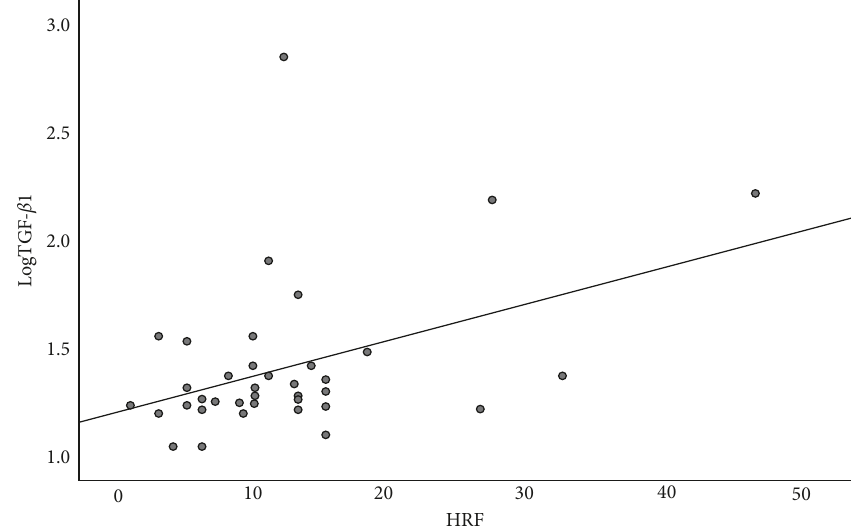
Figure 4: Correlation between aqueous humor TGF- β 1 and HRF in DME patients. Table 3: Univariate and multivariate linear regression analysis for IL-6, FGF, and TGF- β